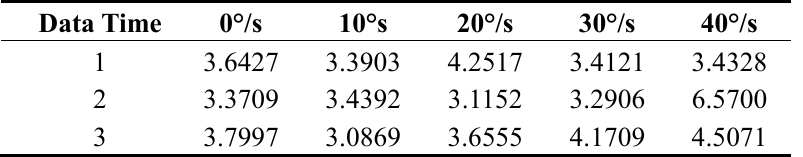
Table 1. Estimation results of the ARW coefficient of the mechanically dithered RLG under different turntable rotation